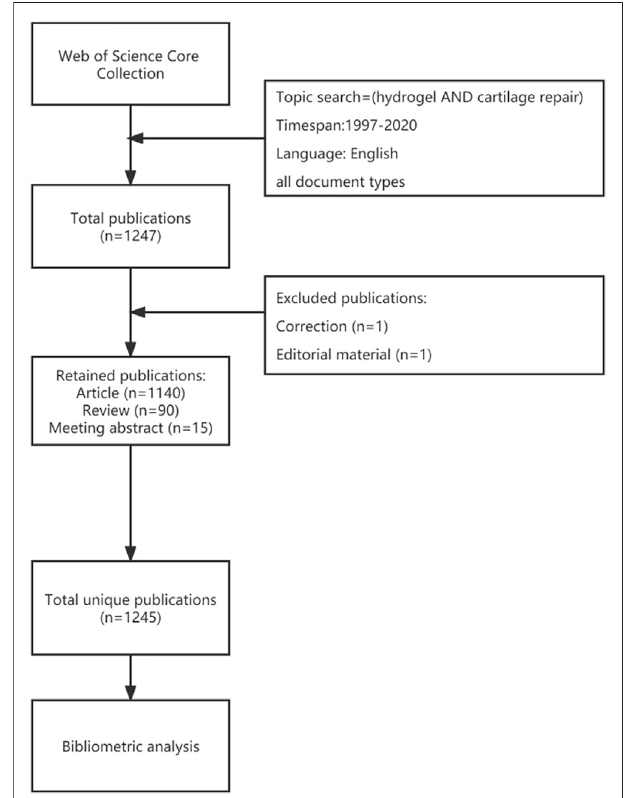
Figure 1 | Flowchart of literature